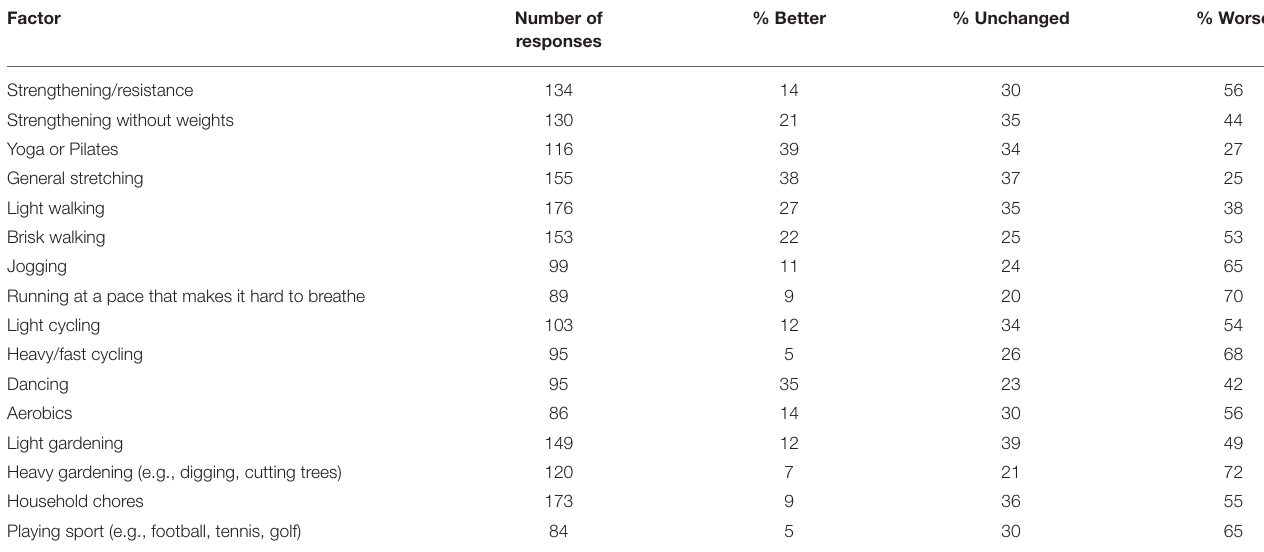
TABLE 6 | Different modes of exercise and the impact on dystonia symptoms. Factor Number of